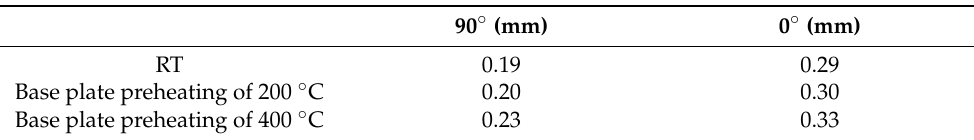
Table 2. Maximum value of the deformation of the top surface as a function of the orientation of the specimen on the build